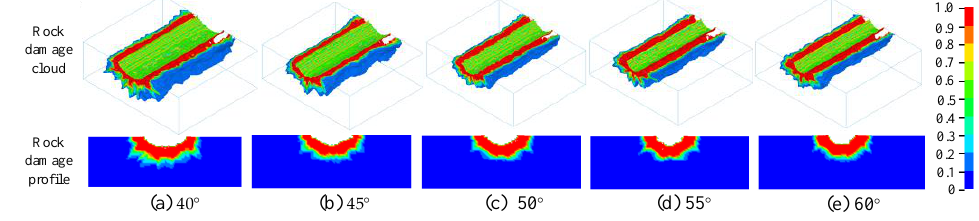
creases, the rock damage volume width decreases obviously, as shown in Figure 11. Due to the increased cutting angle, the contact area of the pick cutting the rock decreases. main position.